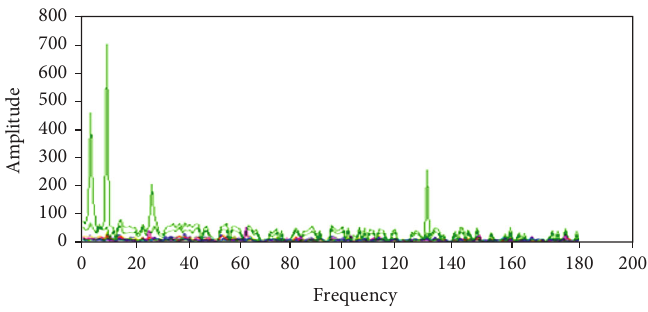
Figure 8: Power spectrum in the case of open